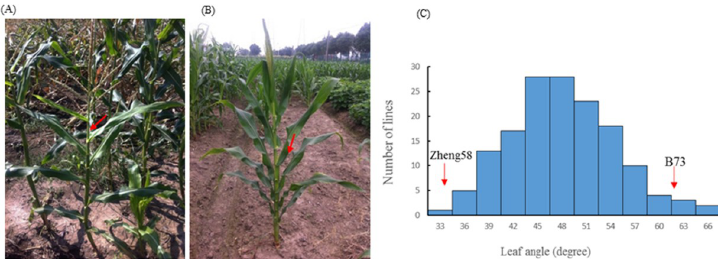
Fig 1. The maize leaf angle trait. (A) Leaf angle phenotype of the expanded inbred line B73. (B) Leaf angle phenotype of the compact inbred line Zheng58. (C) The frequency distribution of leaf angle within the F 3:4 population. The red arrow refers to the mean value of the leaf angle phenotype of the compact inbred line Zheng 58 and the expanded inbred line B73. https://doi.org/10.1371/journal.pone.0245129.g001 transcribed (Vazyme, R323), and then performed Quantitative PCR (Vazyme, Q711). 18S was selected as housekeeping genes for the internal control, and the primers used in the RT-qPCR are listed in S1 Table. Three independent biological replicates were collected for each sample.